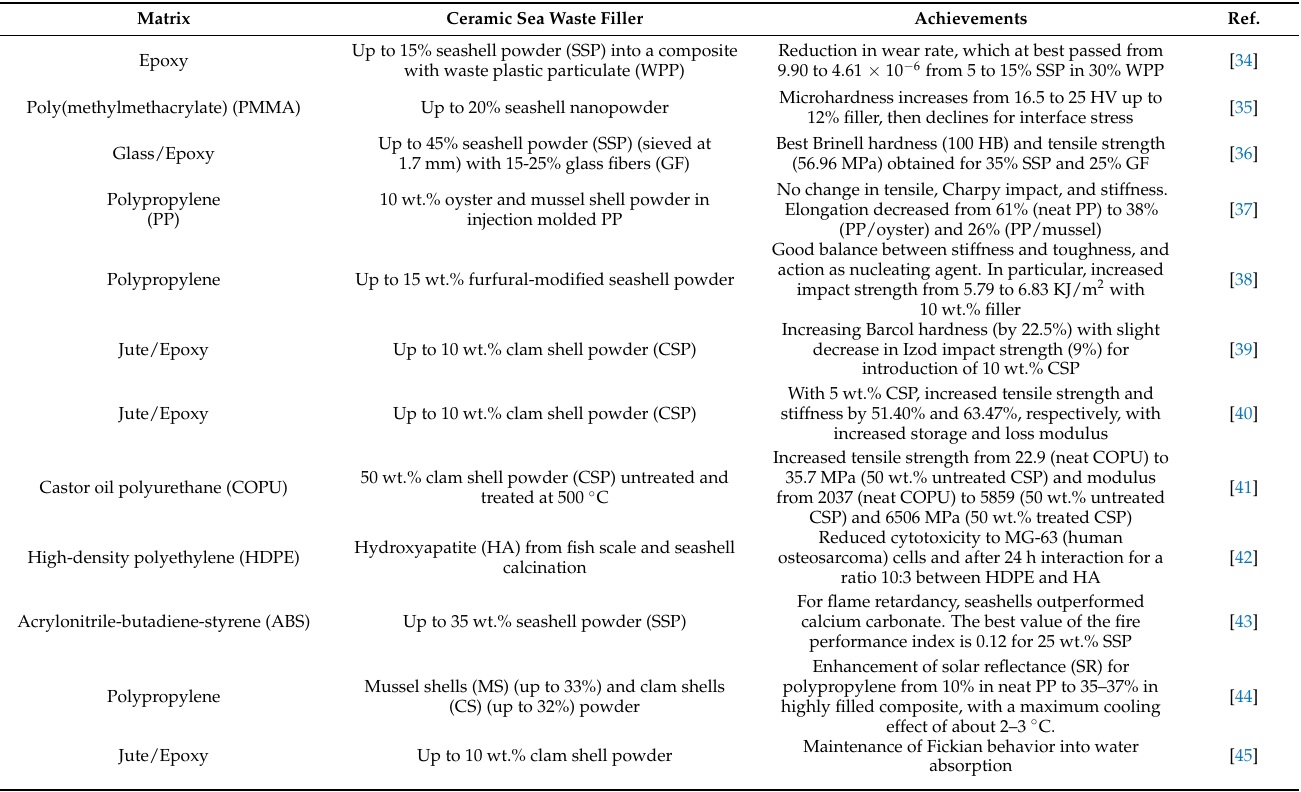
Table 1. Studies on ceramic sea waste in polymer